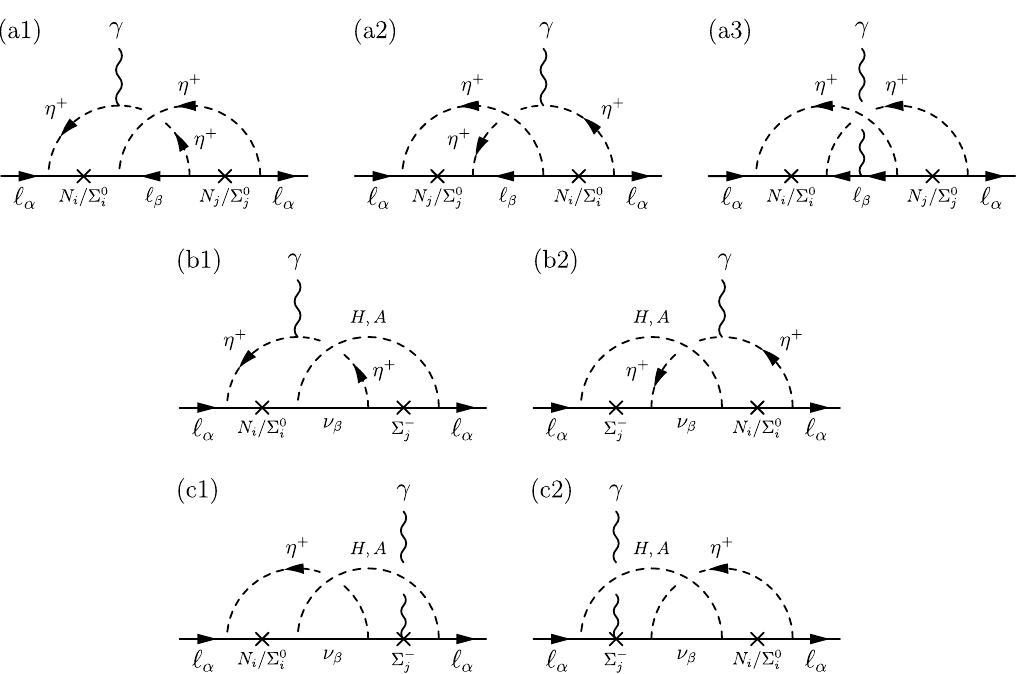
Figure 2 . Majorana type diagrams contributing to charged lepton EDMs. The cross mark